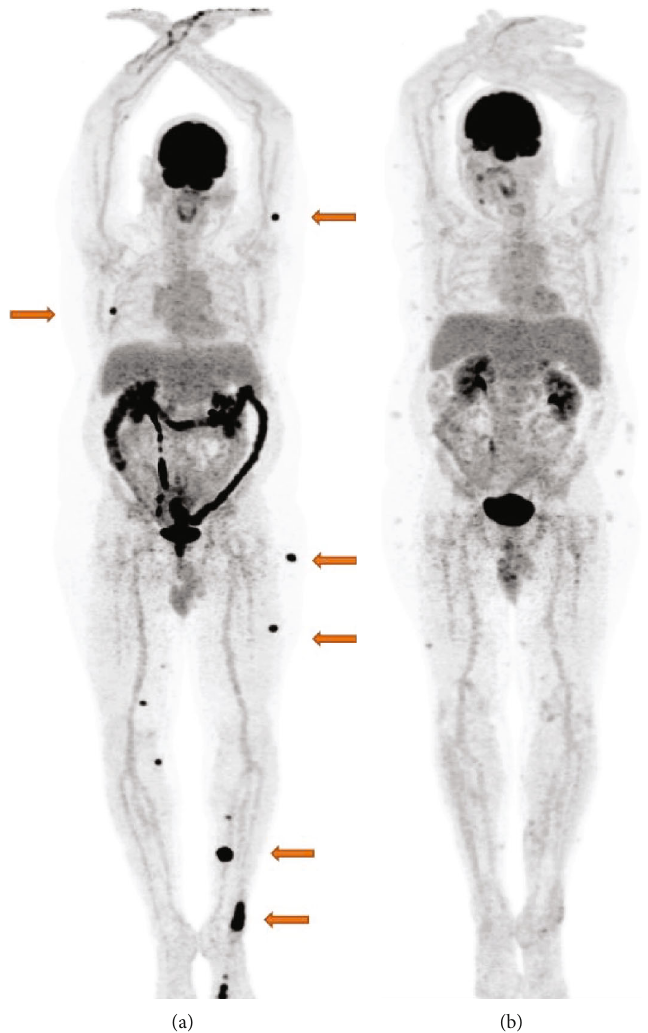
Figure 1: (a) PET/CT scan prior to start of dabrafenib/trametinib combination therapy showing multiple subcutaneous metastases. (b) PET/CT scan 4 months after initiation of BRAFi/MEKi therapy showing resolution of previously noted subcutaneous